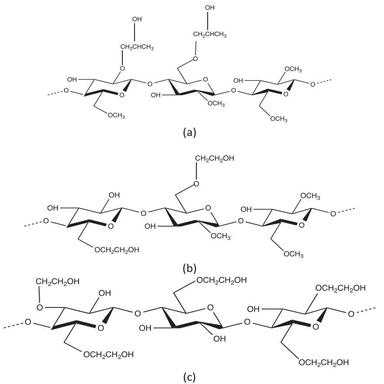
Structure of cellulose ethers (a) HPMC; (b) HECM; (c) HEC. Reproduced from with permission.